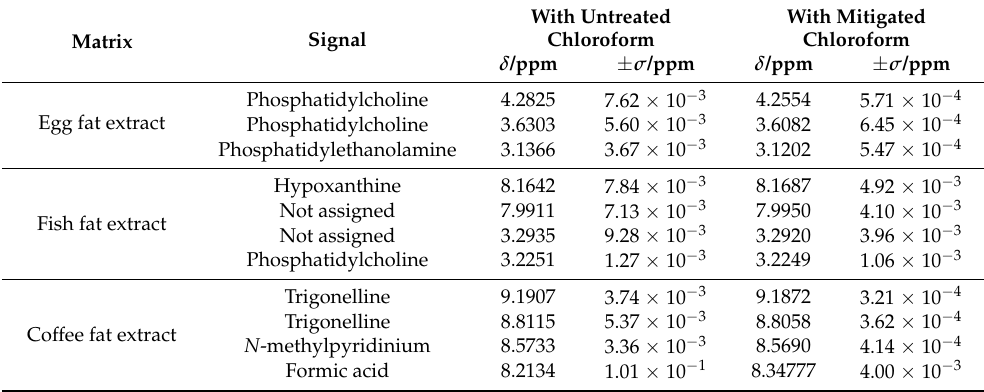
Table 1. Mean values and standard deviations of exemplary NMR signals compared between samples prepared with untreated or mitigated chloroform.